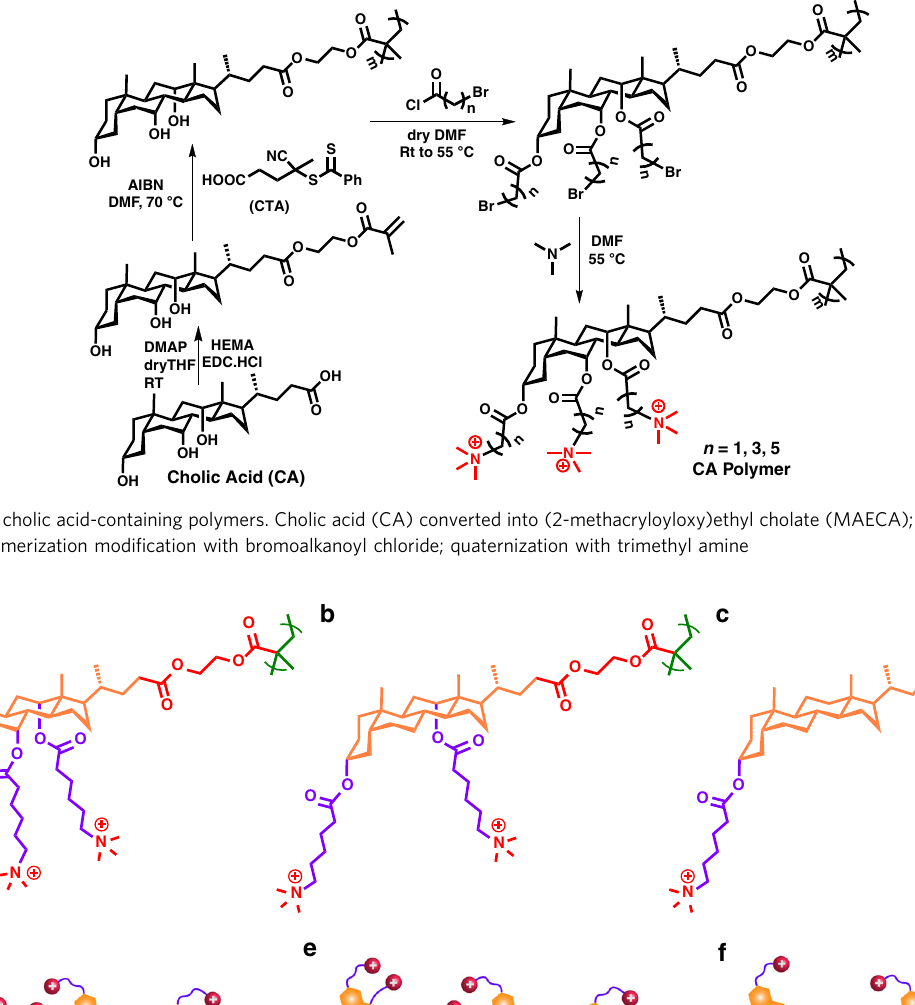
hydroxyl groups in homopolymers. Evidence of successful post- polymerization modi fi cation was also established by the slight shift of GPC traces of polymers before and after modi fi cation (Supplementary Figure 2c). Finally, the bromine groups were substituted by trimethylamine to offer quaternary ammonium- containing polymers. The appearance of an intense peak at ~3.0